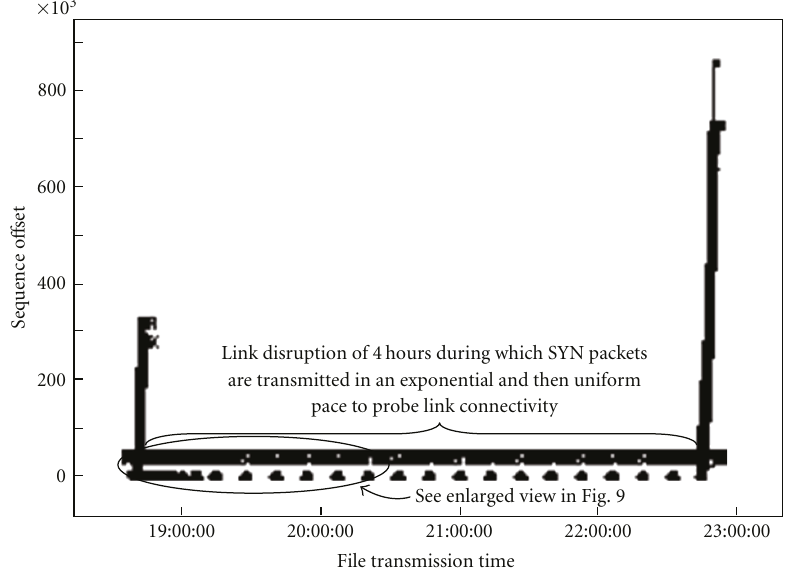
Figure 6: Time Sequence Graph for DTN transmission of 1Mbyte file from MX to RX over cislunar channels with link delay of 3000 ms and link disruption of 4 hours at BER = 10 − 6